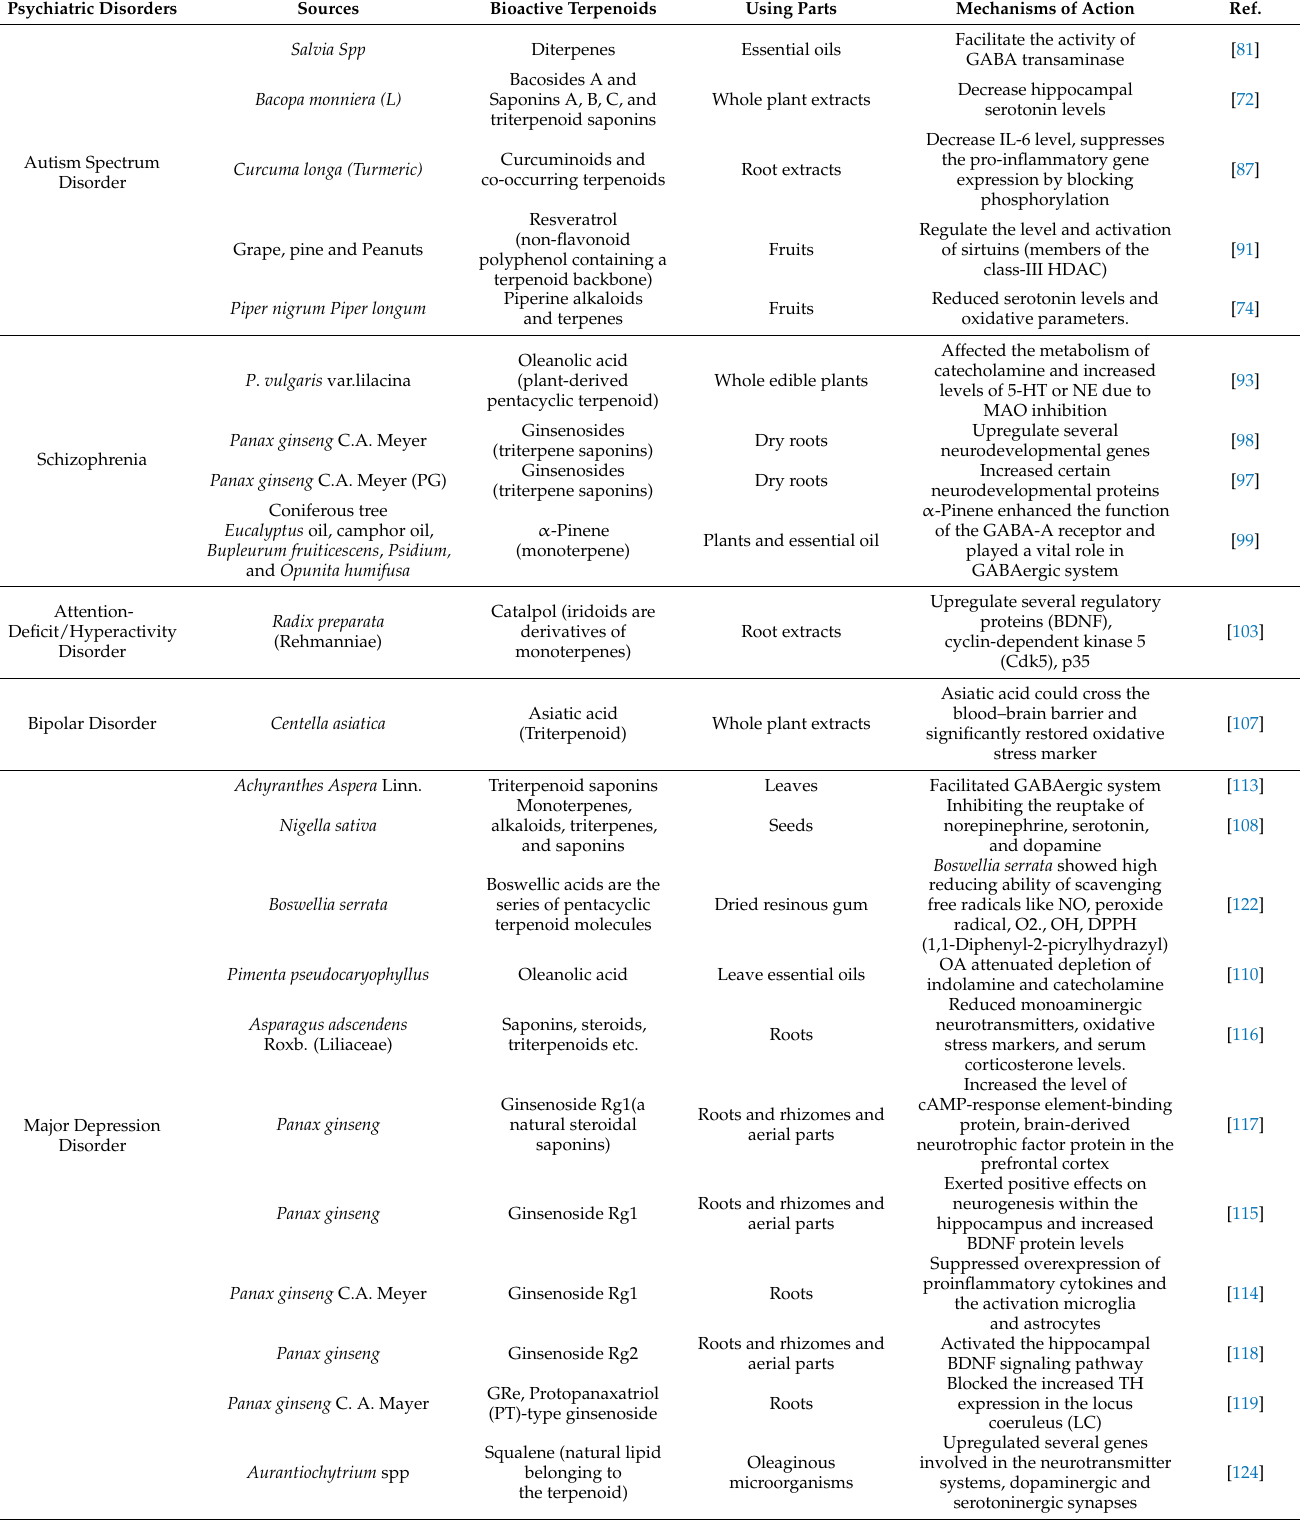
Table 1. Bioactive terpenoids, their sources and mechanisms of action in psychiatric